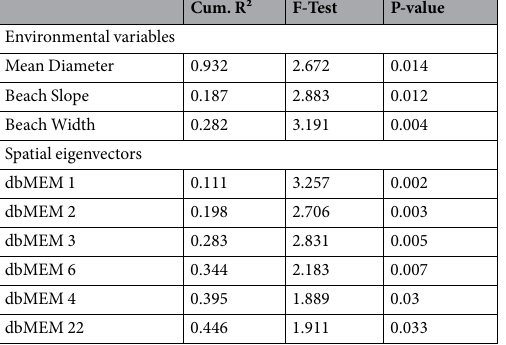
Table 2. Variables selected by forward procedure for the environmental and spatial components. Spatial eigenvectors (dbMEMs) with low numbers represent large-scale, whereas high numbers represent small-scale patterns.